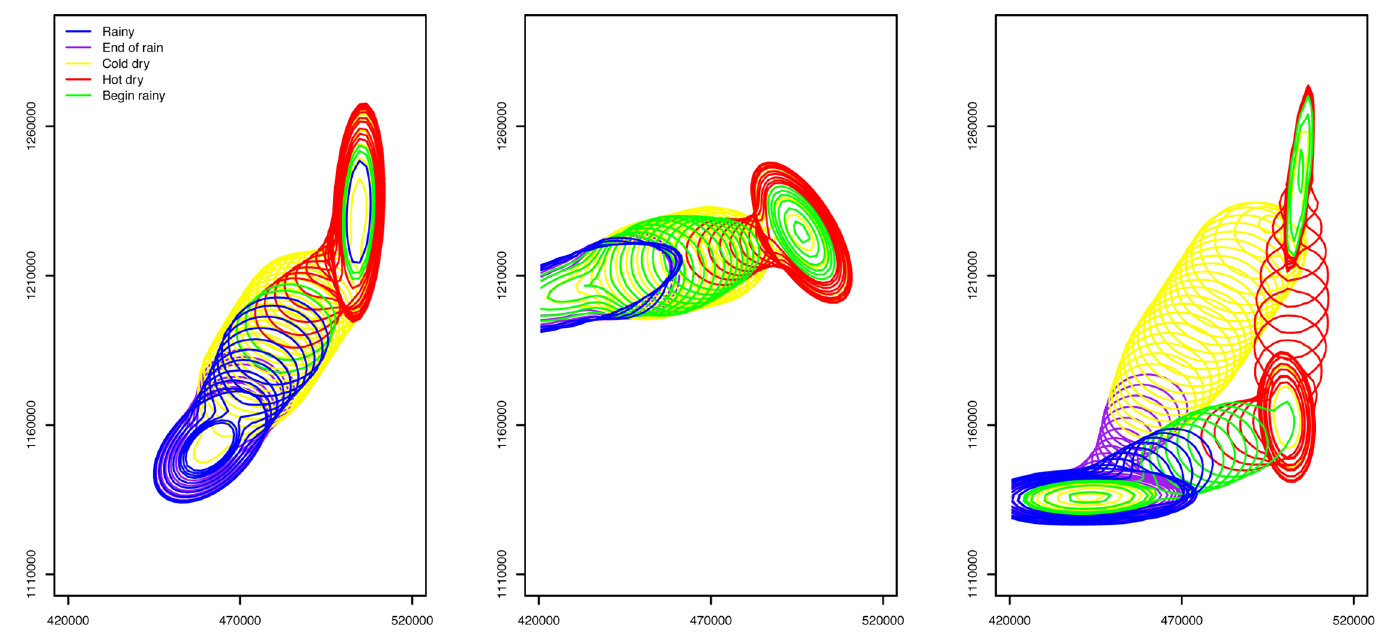
Fig 8. Results from the STM model. Each contour encloses an area where P ( x t = x ) (cid:1) 95%. Each map shows the result after overlaying the contours of every 5 days throughout the year. Groups 1, 2, and 3 are represented in the figures from left to the right. The part of contours outside the study area is not shown in the